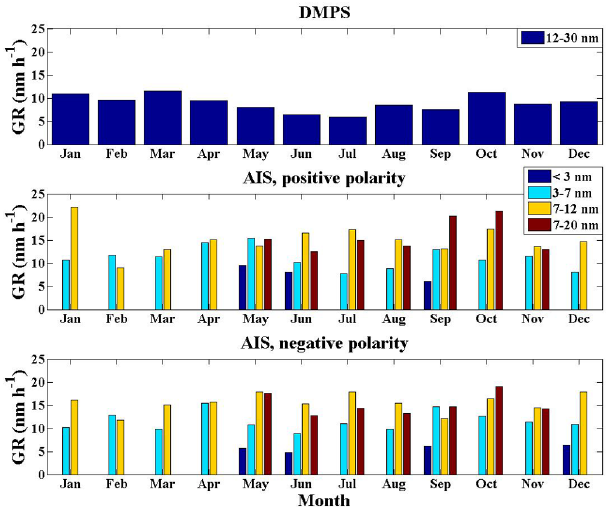
Fig. 13. Annual monthly median growth rates (GR) based on DMPS (upper panel), positive (middle panel) and negative (lower panel) ion data